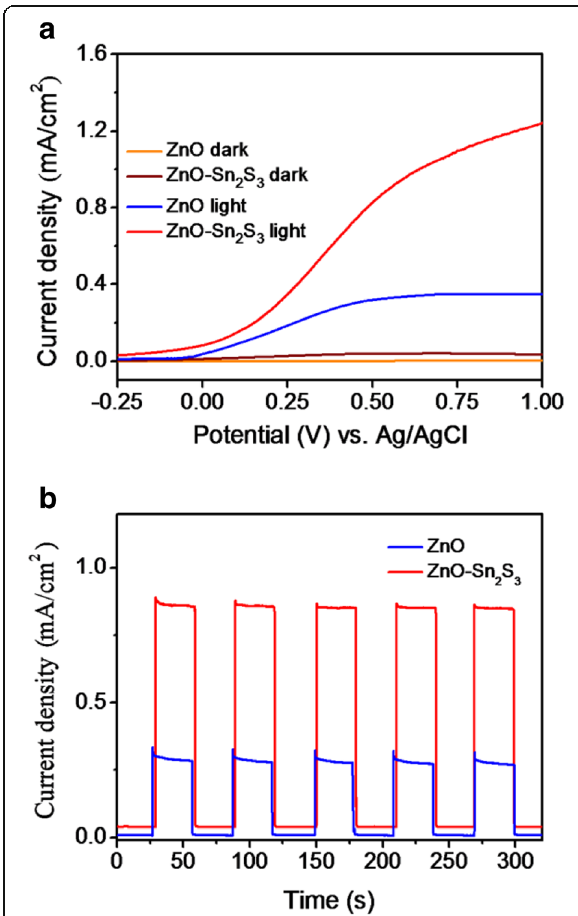
Fig. 6 a Current density vs. potential curves for various nanorod samples with and without light illumination. b Cyclic current density vs. time curves for various nanorod samples under chopped light